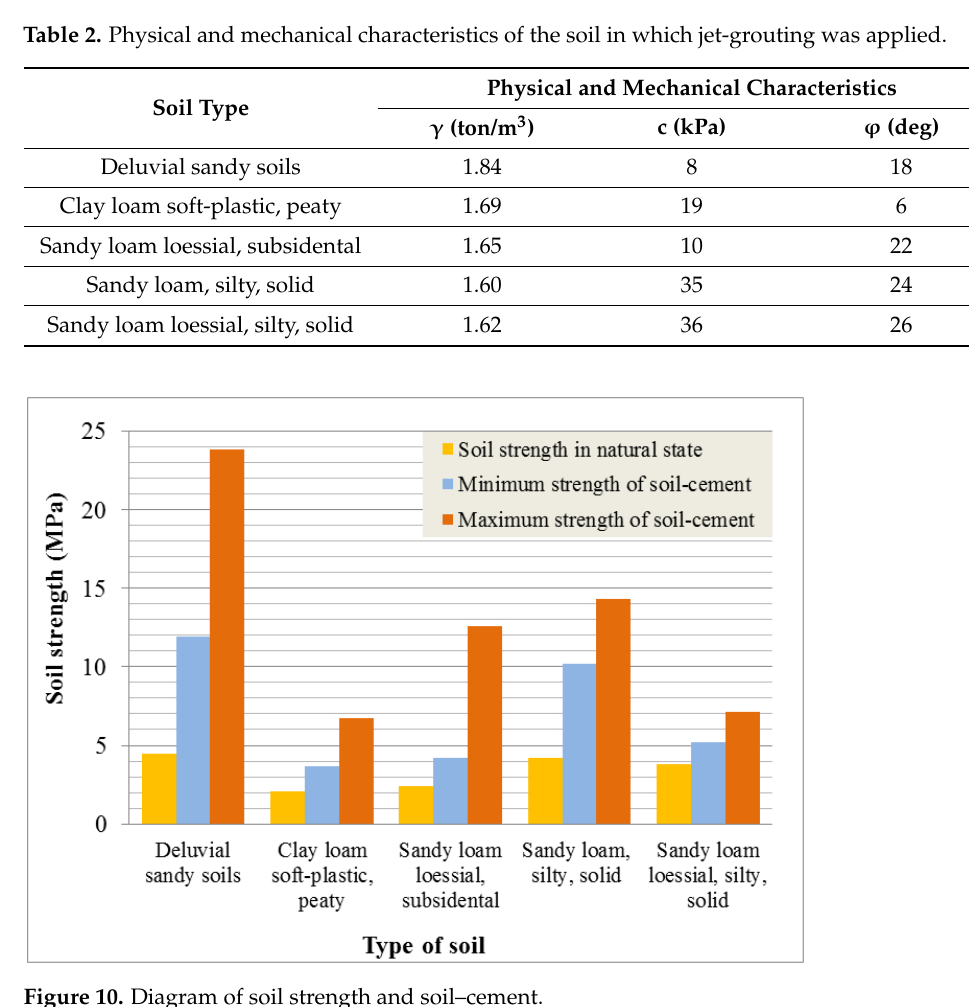
Figure 10. Diagram of soil strength and